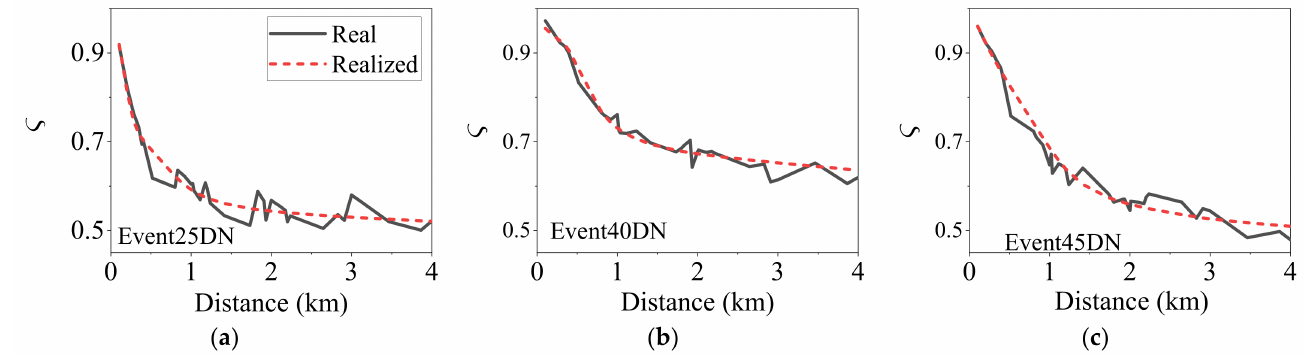
Figure 23. Similarity of the vertical components for ( a ) Event 25, ( b ) Event 40, and ( c ) Event